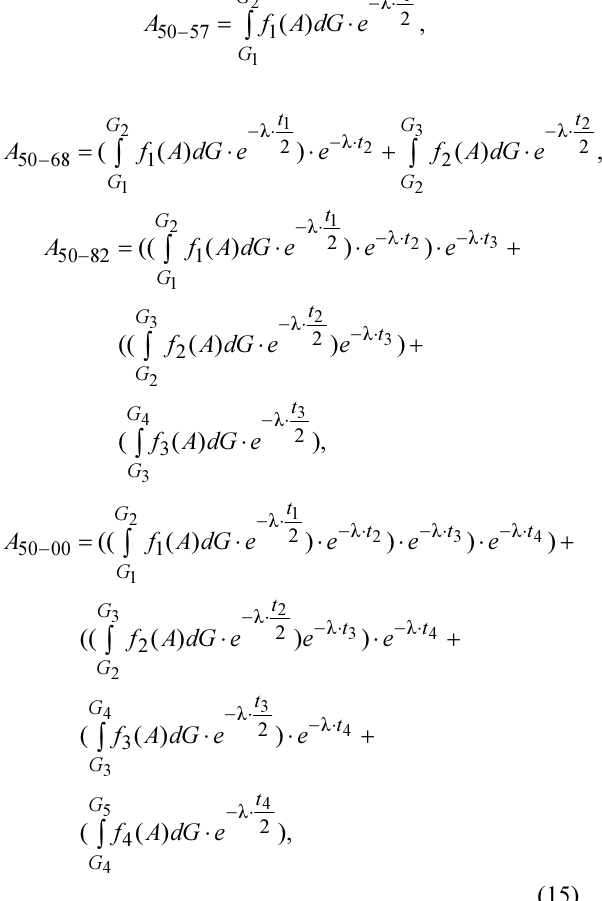
Fig. 6. Relationship between